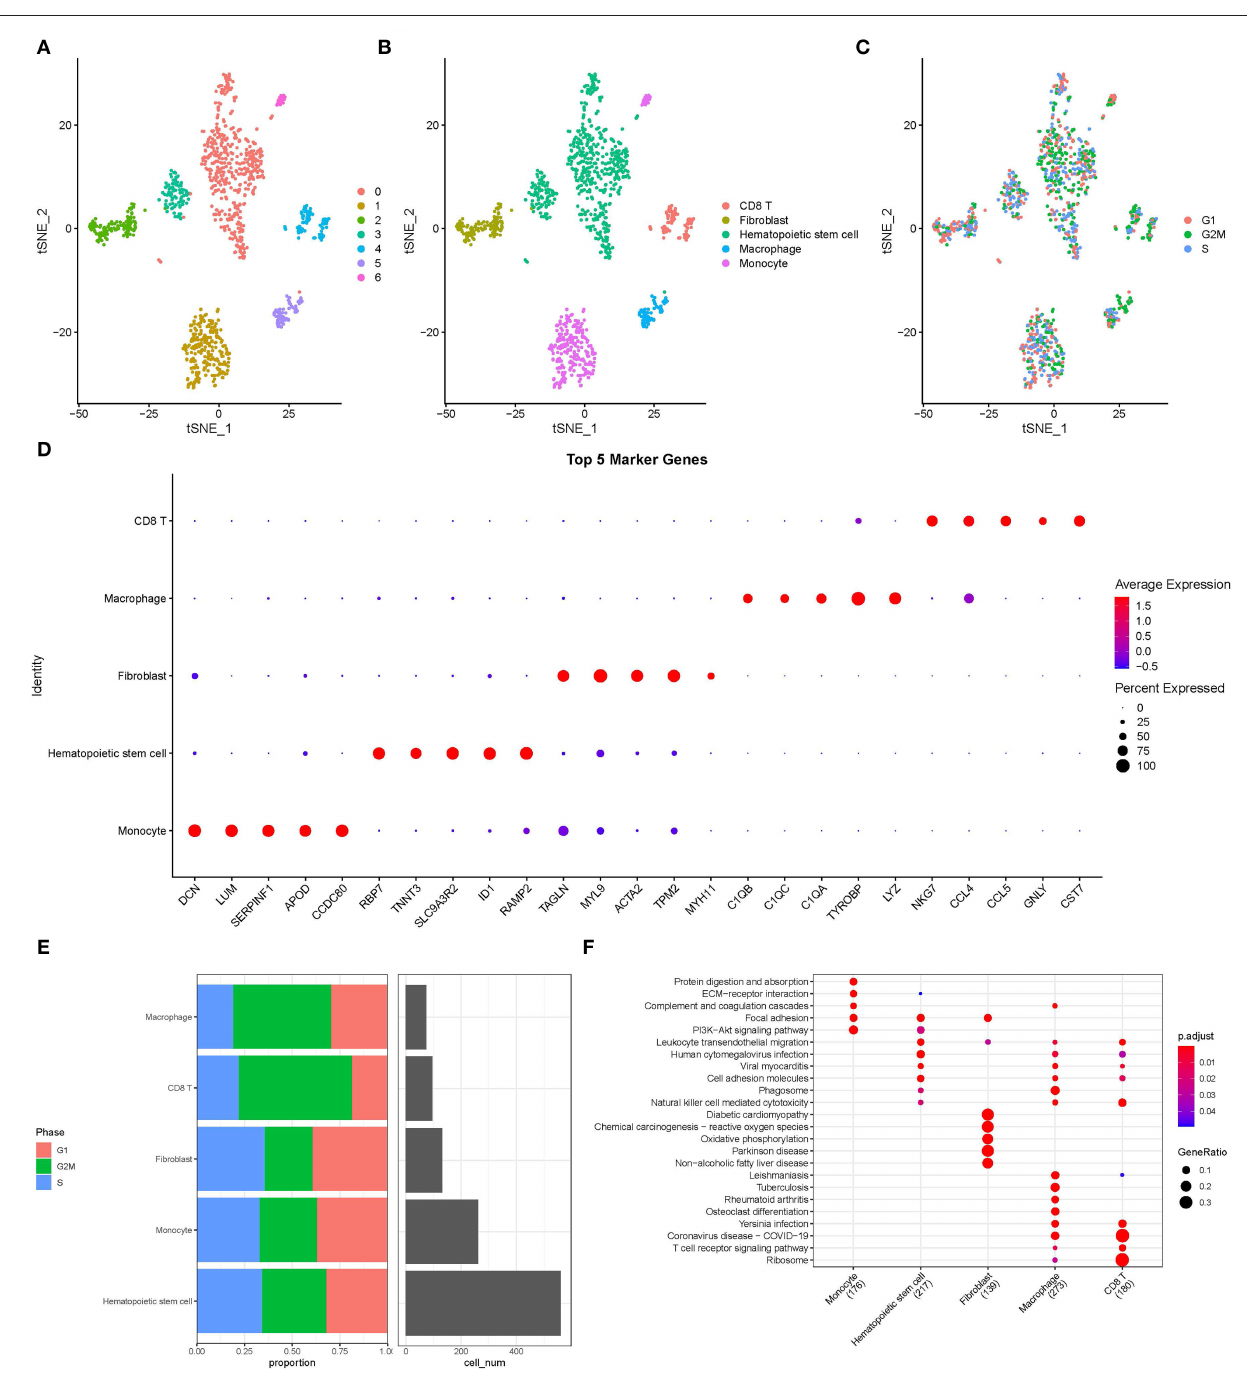
FIGURE 1 | Overview of single cells from acute myocardial infarction and healthy tissues. (A) T-distributed Stochastic Neighbor Embedding (tSNE) of 7 cell clusters. (B) The cell types were identified by marker genes. (C) T-distributed Stochastic Neighbor Embedding of 3 different types (G1, G2/M, and S phase) of sample. (D) The top five marker genes of five cell types. (E) The distribution of G1, G2/M, S phase, and cell numbers in five cell types. (F) The functional enrichment analysis of Kyoto Encyclopedia of Genes and Genomes (KEGG) on maker genes of five cell types.